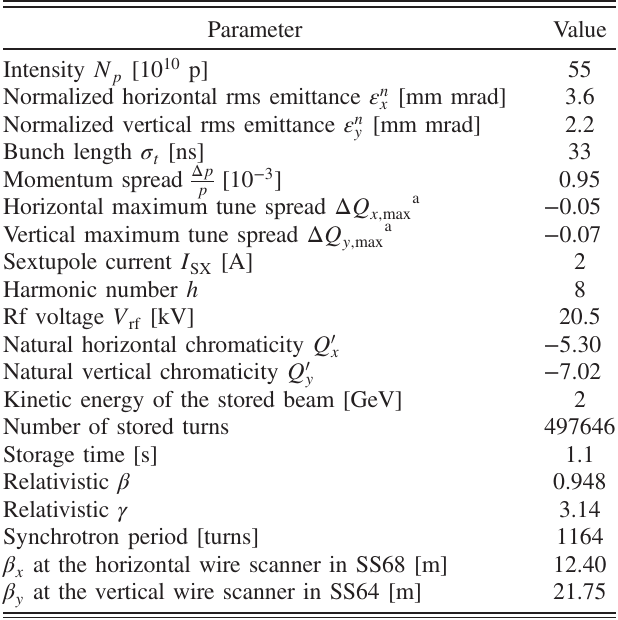
TABLE II. Beam and machine parameters. Parameter